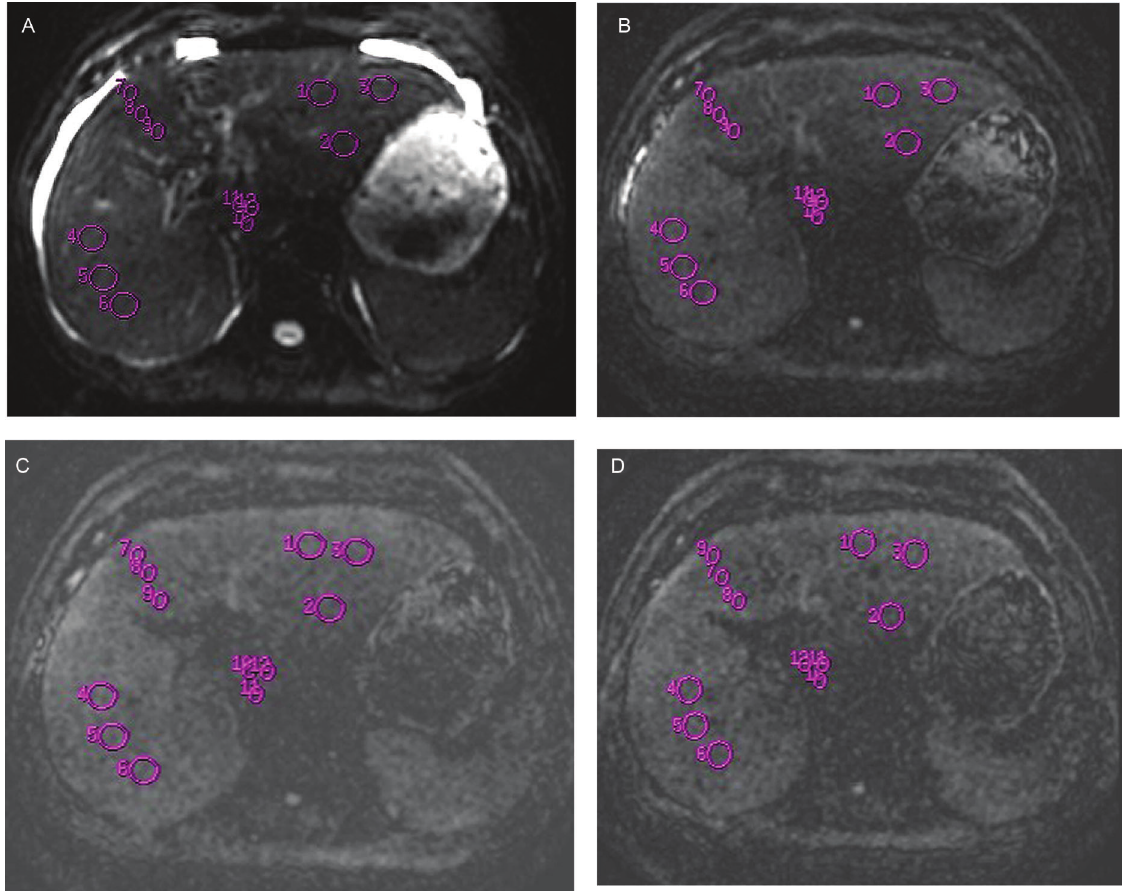
Figure 1 - In a 47-year-old male with Child–Pugh Class C liver cirrhosis, three regions of interest were drawn in each of the left lateral liver lobe, the left medial liver lobe, the right liver lobe, and the caudate lobe for measurement using a b value of 0 sec/mm 2 (A). These regions of interest were identically positioned on the corresponding liver lobes for the measurement of b (0,500) (B), b (0,800) (C) and b (0,1000) (D) by the software to obtain the corresponding apparent diffusion